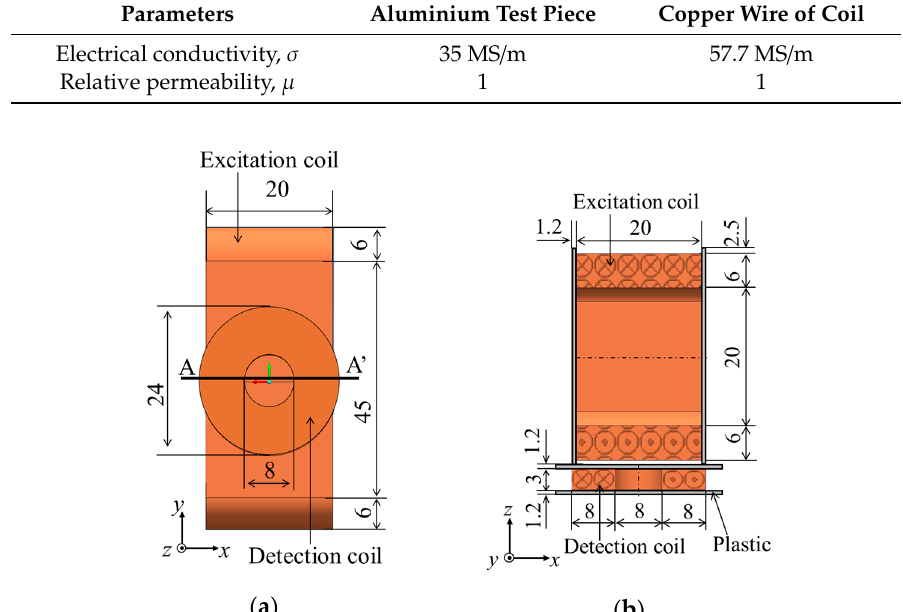
Figure 4. Coil structure of conventional uniform eddy current (UEC) probe (units in mm). The number of turns of an excitation coil is 2000: ( a ) bottom view; ( b ) section view of A-A’.